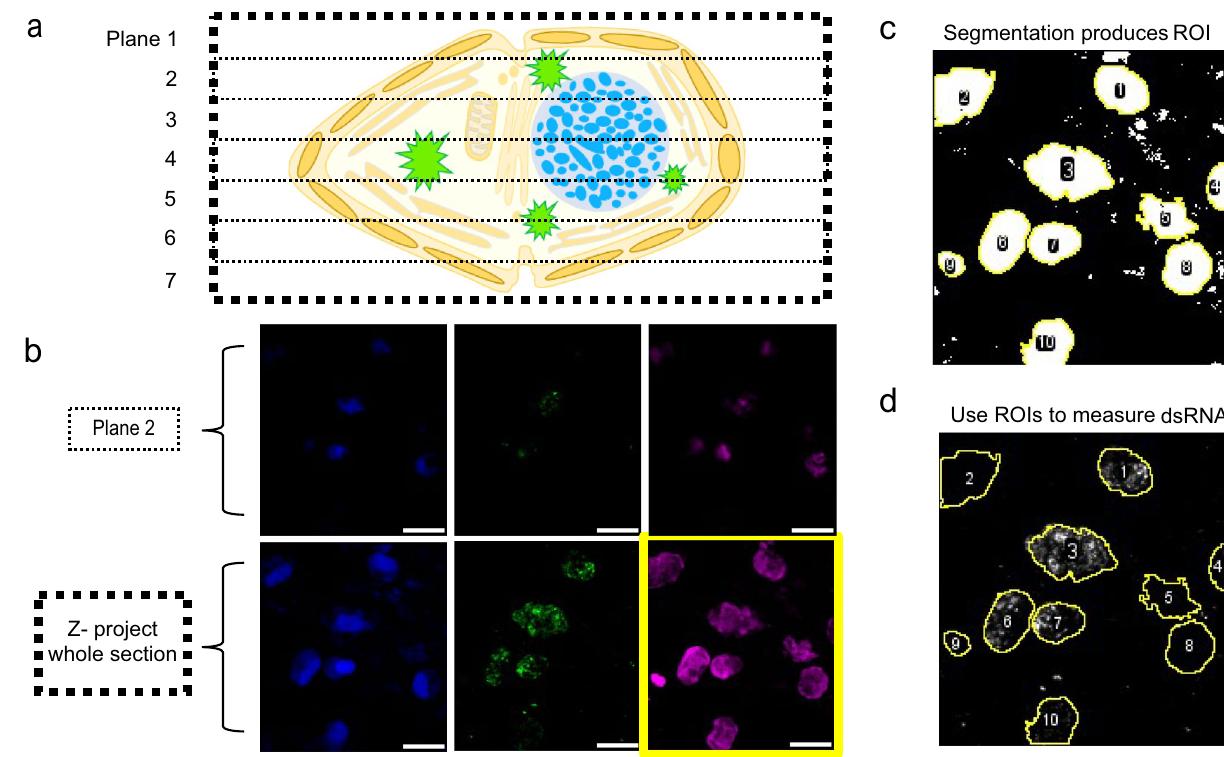
Figure 3. Schematic describing batch processing for quantification of dsRNA. ( a ) Dinoflagellate cells are imaged at z-depth intervals of 1 µm and are denoted here as planes. In reality, whole sections are closer to 20 µm but are reduced here for clarity. ( b ) Imaging of a single plane (e.g., Plane 2) captures only part of the dsRNA signal, while interval imaging of all planes combined with compression into one 2D, maximum intensity Z-projected image allows a complete estimation of dsRNA occurring in the cell. The yellow-outlined chlorophyll-a autofluorescence signal is also required to support automated, quantitative processing. ( c ) Cell boundaries are outlined via segmentation of 2D max intensity Z-projected autofluorescence and saved as regions of interest (ROI). ( d ) ROI are overlaid over each channel image and fluorescence intensity (e.g., dsRNA denoted by AlexaFluor488) is quantified. Scale bars in B = 10